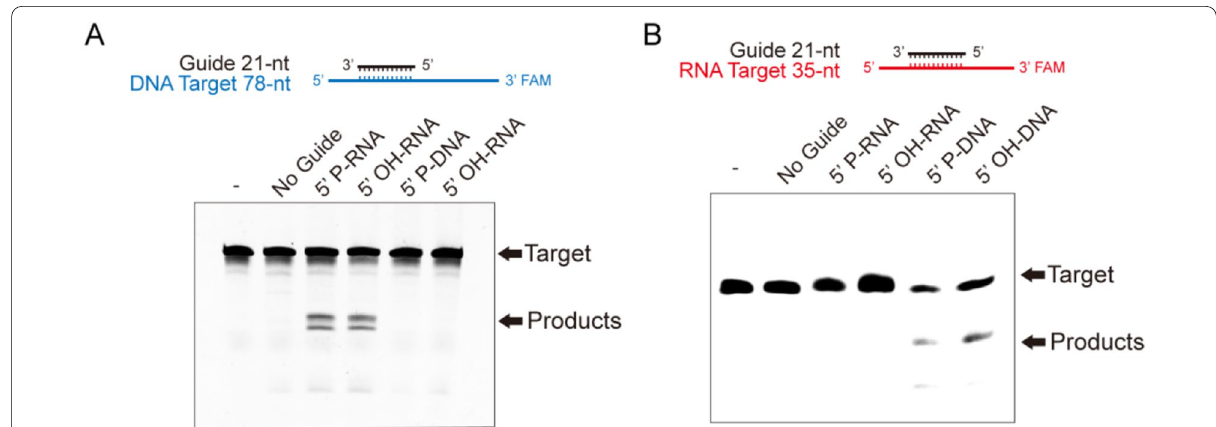
Fig. 2 Ps PIWI-RE possesses RNA-guided DNA cleavage and DNA-guided RNA cleavage activity. A DNA cleavage assays of Ps PIWI-RE were examined in the presence of 21 nt guides with different 5 ′ -terminal modifications, which were as follows: 5 ′ phosphorylated (5 ′ P) DNA, 5 ′ hydroxyl (5’OH) DNA, 5 ′ phosphorylated (5 ′ P) RNA, and 5 ′ hydroxyl (5 ′ OH) RNA. A 78 nt single stranded DNA (ssDNA) with a 3 ′ FAM label was the target sequence. No Guide: reaction without guides. “–”: reaction without guides and Ps PIWI-RE. B RNA cleavage assays of Ps PIWI RE were examined in the presence of 21 nt guides with different 5 ′ -terminal modifications, which were as follows: 5 ′ phosphorylated (5 ′ P) DNA, 5 ′ hydroxyl (5 ′ OH) DNA, 5 ′ phosphorylated (5 ′ P) RNA, and 5 ′ hydroxyl (5 ′ OH) RNA. A 35 nt single-stranded RNA (ssRNA) with a 3 ′ FAM label was the target. The oligonucleotide sequences of the guide strands and target strands are shown in Additional file 1: Table